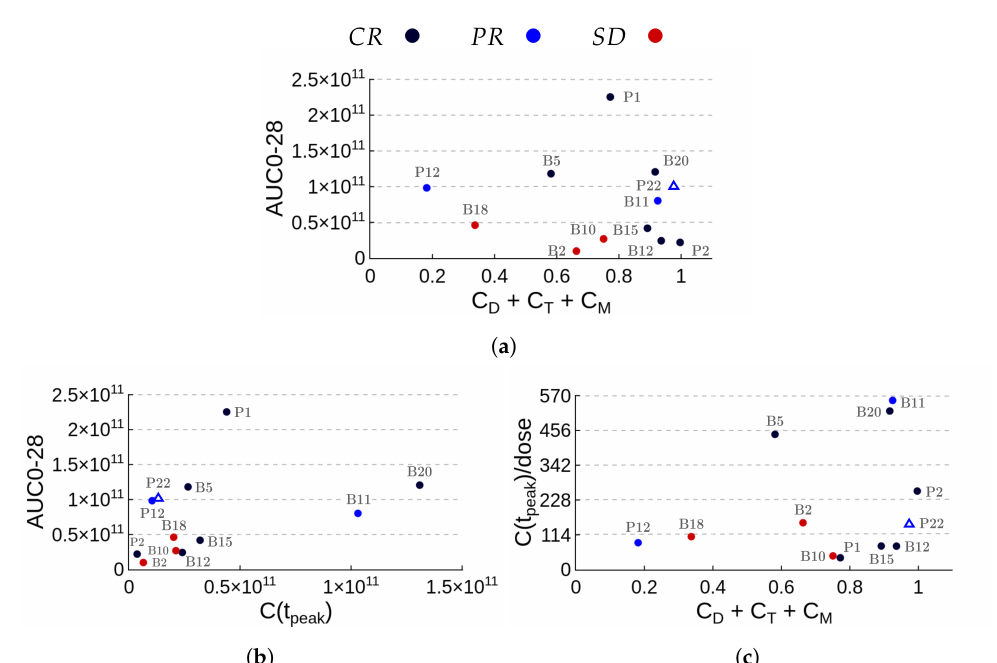
Figure 6. Summary of patient outcomes with respect to kinetic parameters in appropriate units. Panel ( a ) highlights the importance of the fraction of non-exhausted cells ( C D + C T + C M ) in the first 28 days after infusion together with AUC0-28. Patient outcomes are concentrated in three distinct regions. Fully responsive patients (CR) have high fractions of non-exhausted cells while patients who achieved stable disease (SD) have small AUC0-28 values with fractions of non-exhausted CAR-T cells below 0.8. Of the three patients who achieved partial response (PR), patient P12 displays a moderate value of AUC and a high percentage of exhausted cells. Patients P22 and B11 also have moderate AUC values but a small fraction of exhausted cells. Of note, there is no information on the cause of patient B11 relapse but patient P22 (marked with (cid:52) ) underwent mutation with CD19-dim cells. The relationships between AUC0-28 and C ( t peak ) ( b ), and C ( t peak ) /dose and fractions of C D + C T + C M ( c ) are also considered but do not provide clear separation among the response